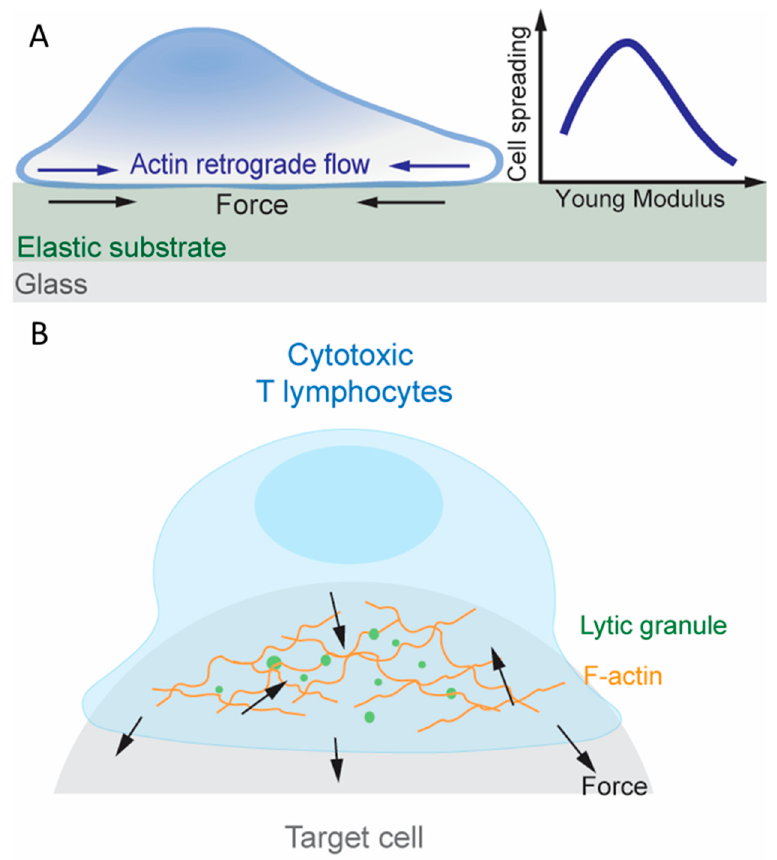
Figure 3. Deformation exerted by naïve T cells and cytotoxic lymphocytes. Schematics depicting how naïve and cytotoxic T cells deform their target substrates. ( A ) Cell spreading is most optimal when the Young’s modulus of the substrate is on the order of 10–100kPa. ( B ) Cytotoxic T lymphocytes (CTLs) spatially coordinate F-actin polymerization and lytic granule localization to mechanical hotspots where force can potentiate the release of granules.